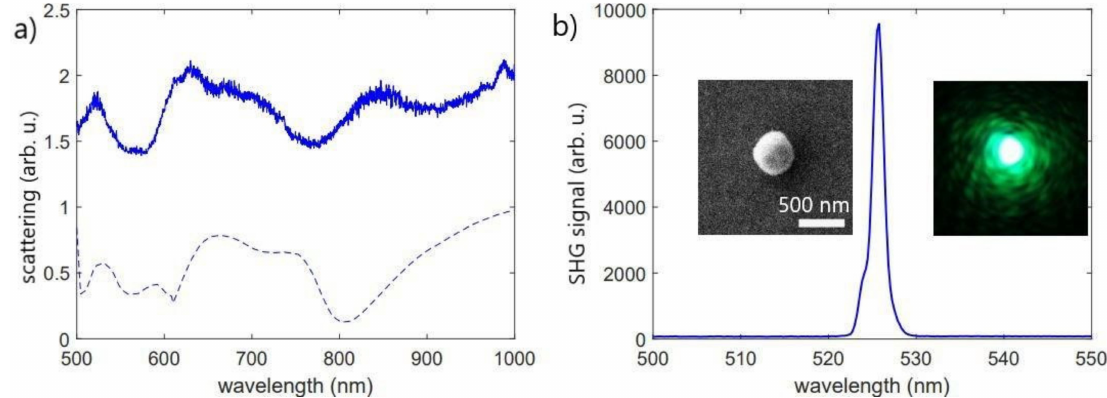
Figure 4. ( a ) Experimental (solid line) and simulated (dashed line) spectra of elastic scattering of light from single BTO nanoparticle; ( b ) experimental SHG spectrum for the same single BTO nanoparticle, left inset: SEM image of BTO nanoparticle; right inset: image from CCD